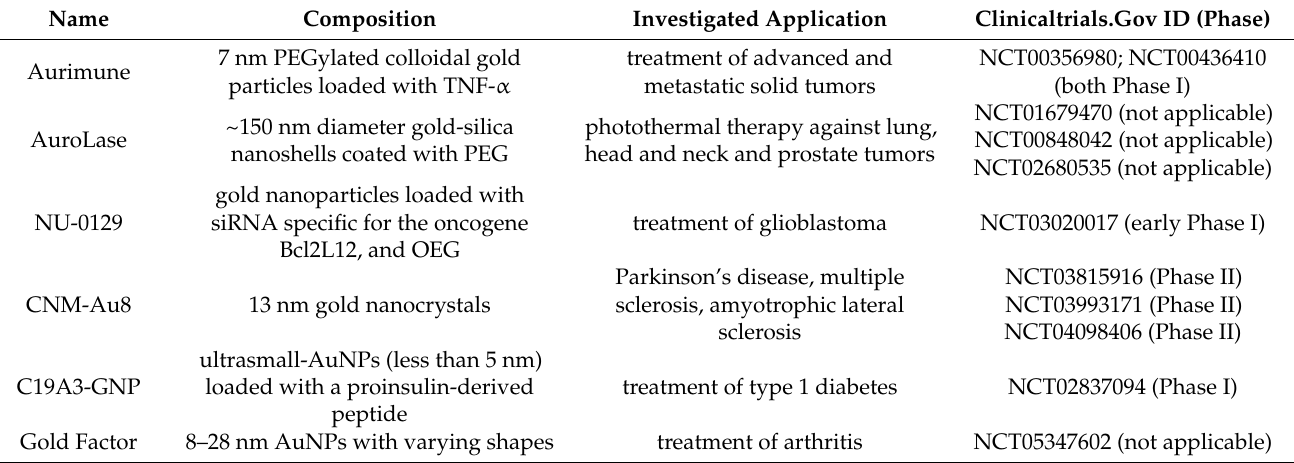
Table 1. Gold-based nanoplatforms investigated in clinal trials (https://clinicaltrials.gov/ (accessed on 1 December